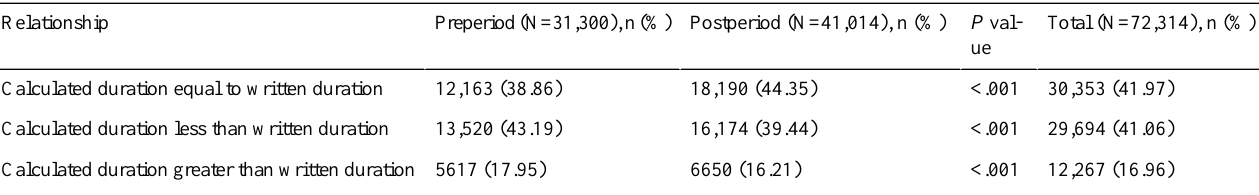
Table 2. Totals and percentages of each cohort and their associated relationships for pre- and